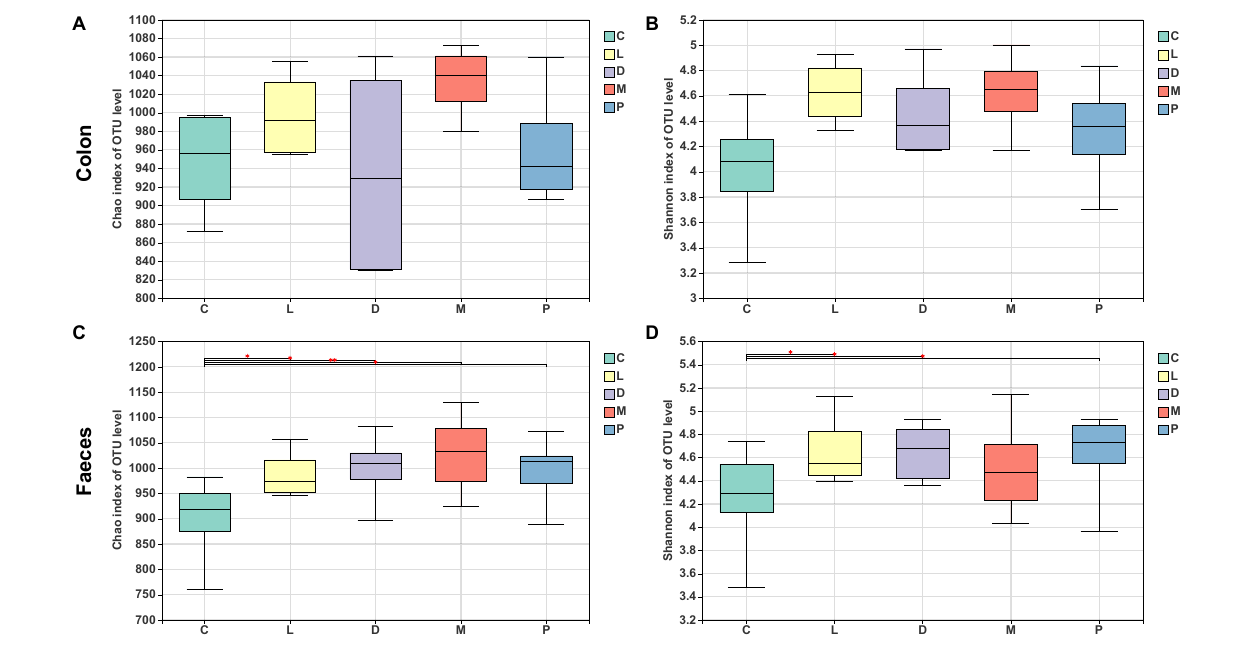
FIGURE 4 | Alpha-diversity of colonic and fecal bacterial communities of piglets. (A) Bacterial richness in the colon estimated by the Chao 1 value. (B) Bacterial diversity in the colon estimated by the Shannon index. (C) Bacterial richness in the feces estimated by the Chao 1 value. (D) Bacterial diversity in the feces estimated by the Shannon